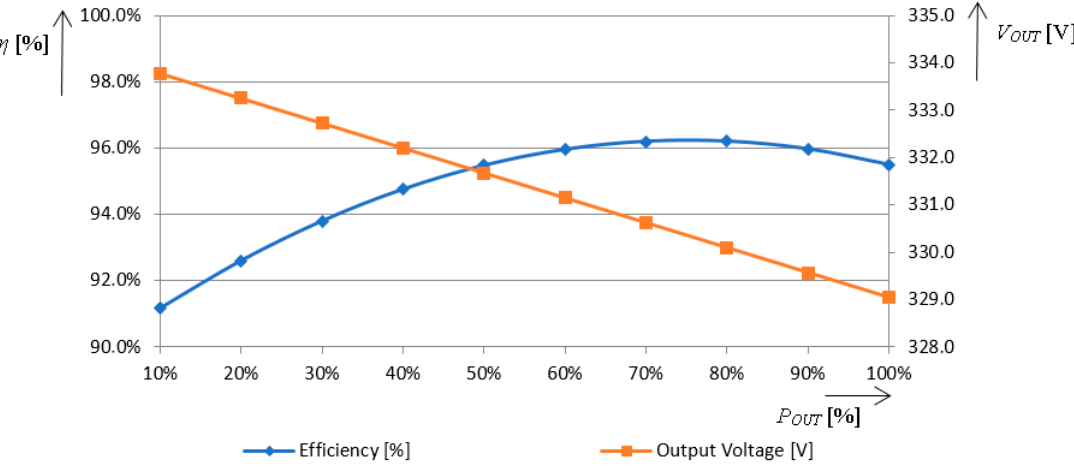
Figure 18. Voltage and current waveforms of the power diodes D 3 , D 4 (100% of output power)— measurement.